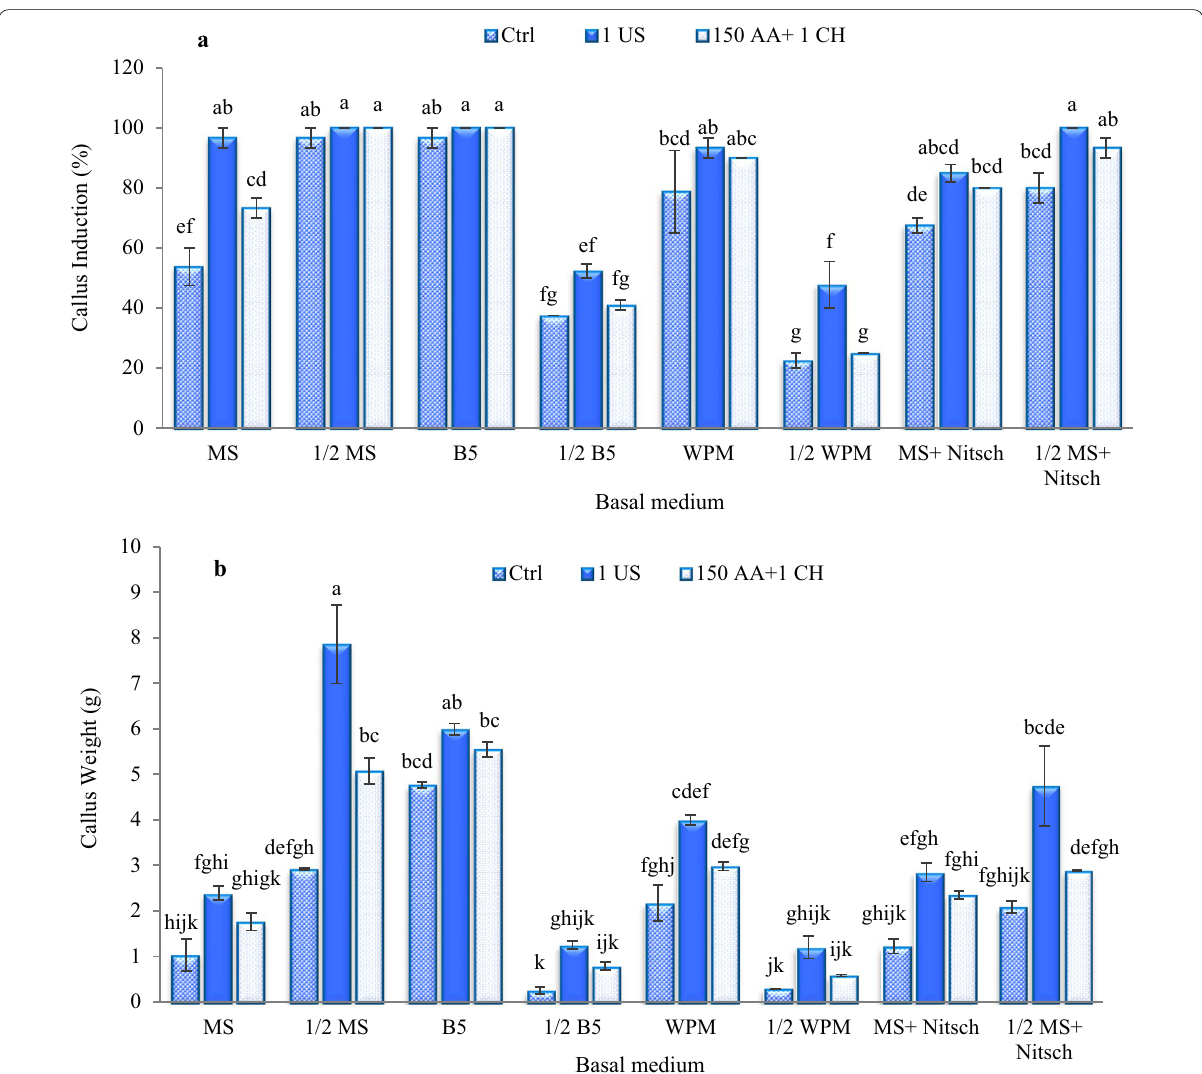
Fig. 3 The influence of basal medium, US treatment, AA, and CH on the percentage of callogenesis ( a ) and fresh callus weight ( b ) of hazelnut explant in the medium containing 2 mg/L 2,4‑D and 0.2 mg/L Kin. According to Duncan’s multiple range tests, values with common letters are not significantly different at the 5% probability